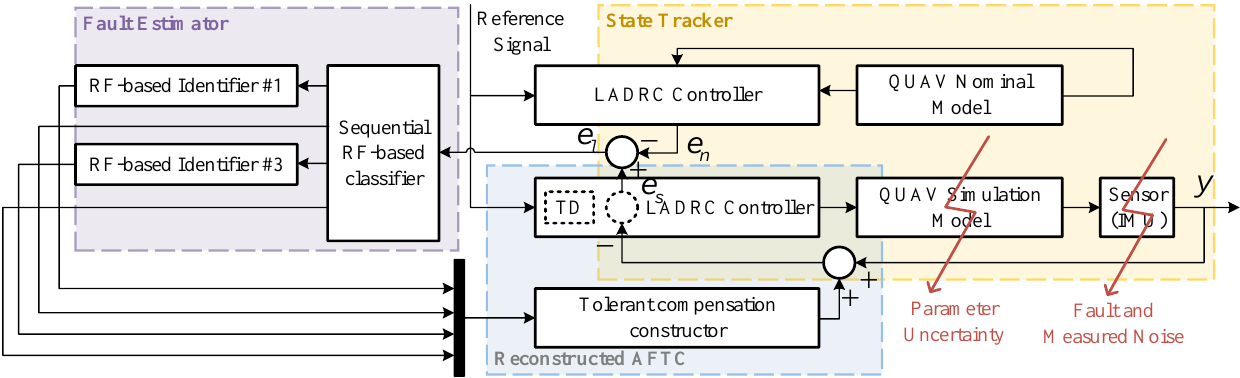
Figure 3. Overview of the LADRC-based AFTC for the QUAV with sensor